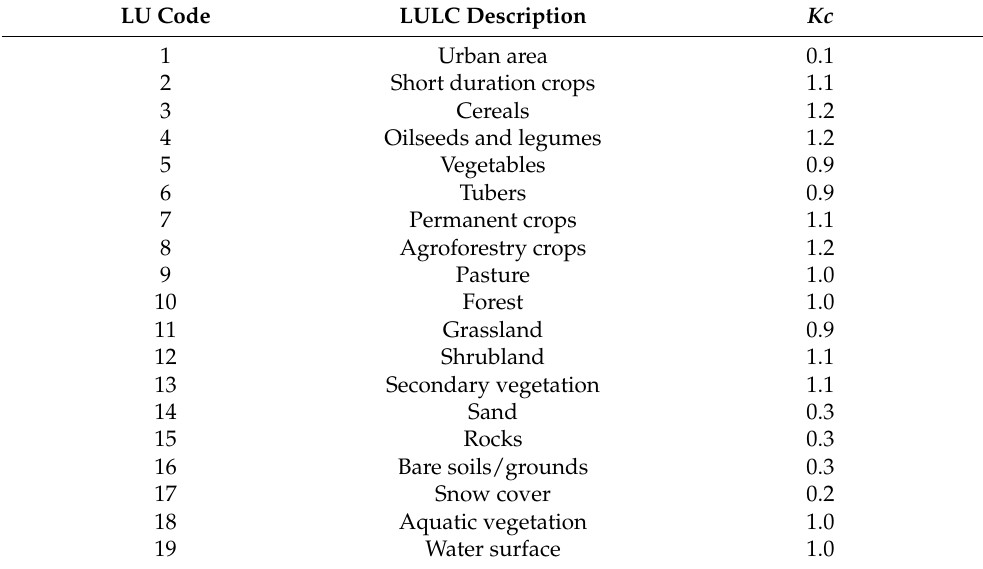
Table 2. Crop coefficient ( Kc ) and land use/land cover (LULC) used in the biophysical table.